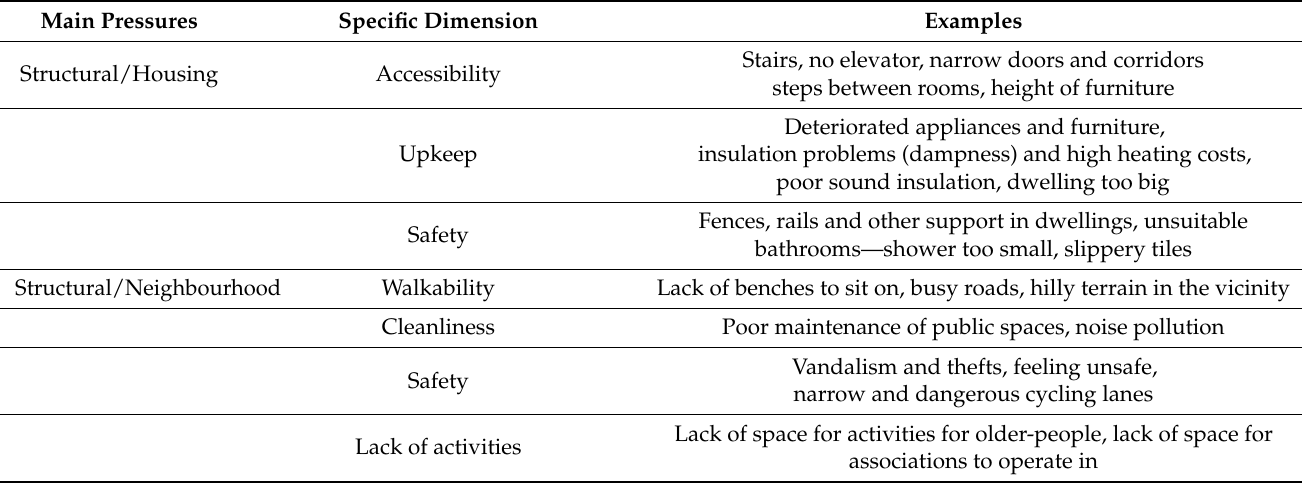
Table 1. Environmental pressures in urban neighbourhoods in